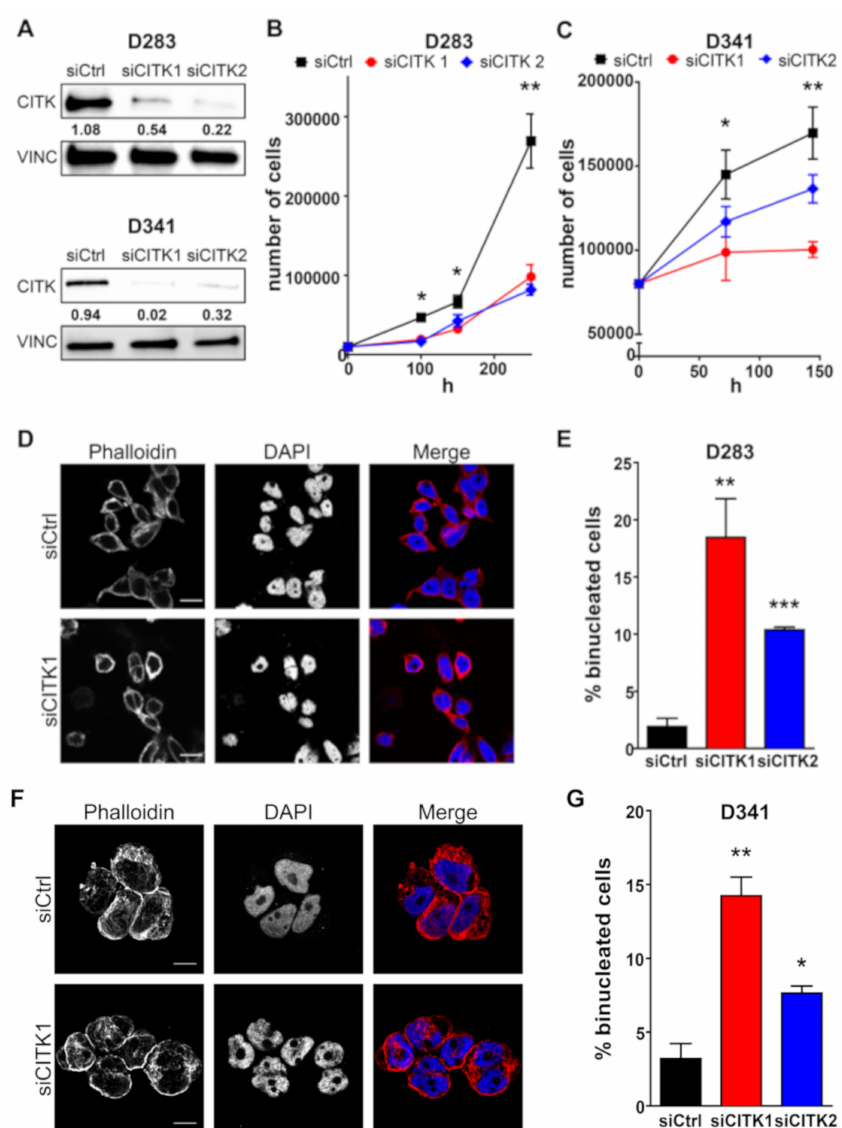
Figure 1. CITK knockdown decreases proliferation and induces cytokinesis failure in medulloblastoma cell lines. ( A ) Western blot analysis of total lysate from D283 and D341 cells, 72 h after treatment, with nontargeting (siCtrl) or CITK-specific siRNAs (siCITK1 and siCITK2). The level of CITK was analyzed, and the internal loading control was vinculin (VINC). The numbers below each band express the ratio between its normalized intensity and the average normalized intensity of the siCtrl. ( B ) 10,000 D283 cells were transfected with siCtrl, siCITK1 and siCITK2 and plated in triplicates. Growth curves were obtained by assessing cell number in each well, at 100, 150 and 200 h after transfection. ( C ) 80,000 D341 cells were transfected with siCtrl, siCITK1 and siCITK2 and plated in triplicates. Growth curves were obtained by assessing cell number in each well at 72 and 144 h after transfection. ( D ) Representative image of D283 cells processed for immunofluorescence 100 h after transfection with nontargeting or CITK-specific siRNA and stained with DAPI and anti-Phalloidin antibody. ( E ) Quantification of binucleated D283 cells in the indicated transfections, performed as in ( D ). ( F ) Representative image of D341 processed for immunofluorescence 72 h after transfection with nontargeting or CITK-specific siRNA and stained with DAPI and anti-Phalloidin antibody. ( G ) Quantification of binucleated D341 cells in the indicated transfections, performed as in ( F ). All quantifications were based on three independent biological replicates. Error bars, SEM. *, p < 0.05; **, p < 0.01, ***, p < 0.001; two-tailed Student’s t -test. Scale bars, 10 µ